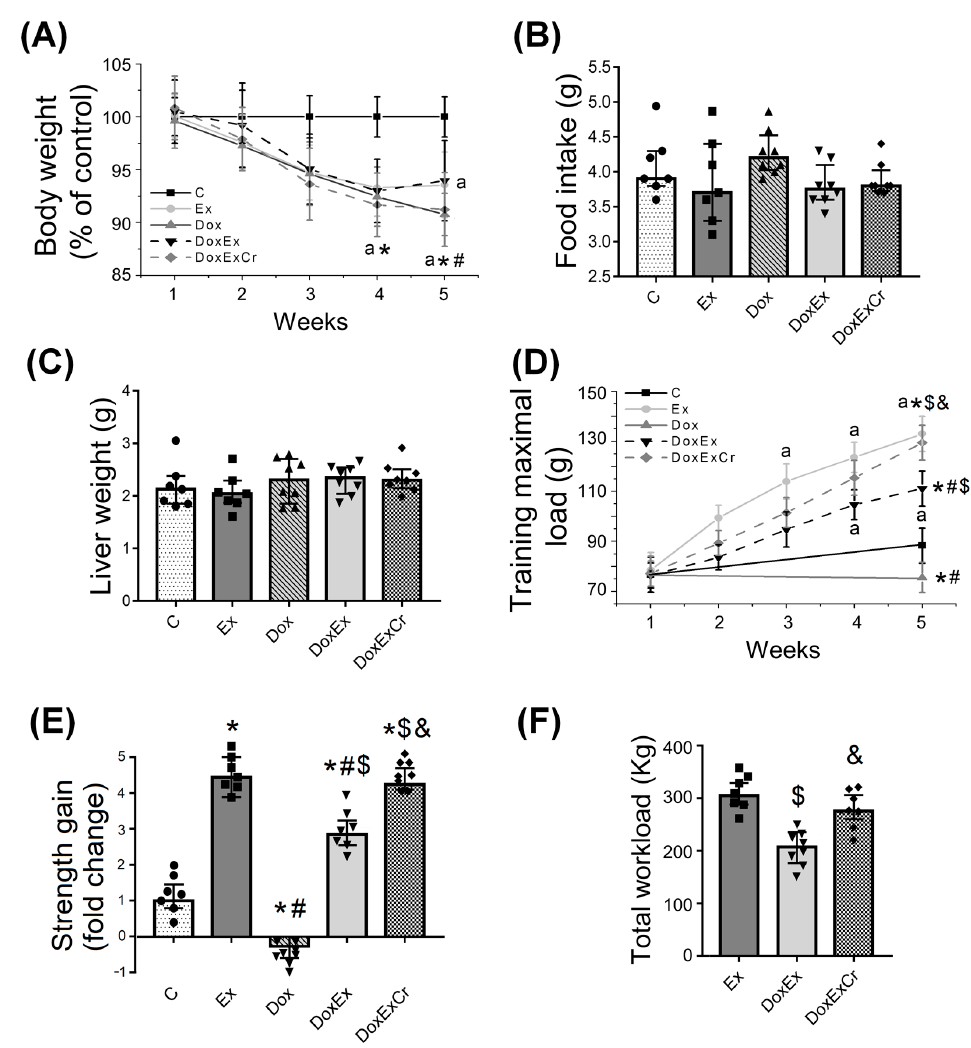
Figure 1. Creatine supplementation potentiates protective effects of ST by enhancing training load capacity and strength gain. Weekly changes in ( A ) total body weight, average ( B ) food intake, and ( C ) liver weight. Changes in ( D ) training maximal load over 5 weeks, ( E ) strength gain, and ( F ) total workload for groups control (C, n = 7), exercised (Ex, n = 7), treated with doxorubicin (Dox, n = 8), treated with doxorubicin and exercised (DoxEx, n = 8), and treated with doxorubicin, exercised, and supplemented with creatine (DoxExCr, n = 8). Data are expressed as mean ± SD. Between-group differences were assessed by two-way ANOVA using Tukey’s post hoc test with p < 0.05 considered statistical significance. * indicates a significant difference from control group; # indicates a significant difference from the exercised group; $ indicates a significant difference from the doxorubicin-treated group; and & indicates a significant difference from the doxorubicin-treated exercised group. a Indicates a significant difference from weeks